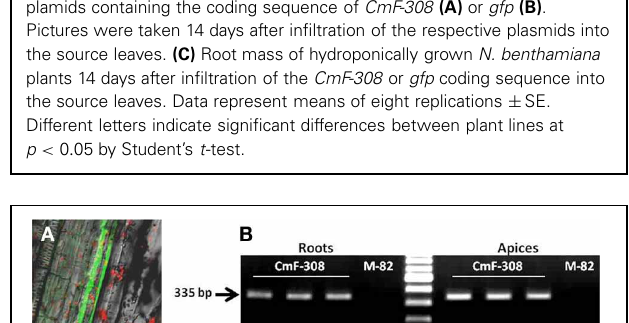
FIGURE 2 | Presence of CmF-308 transcript in the stems and apices of N. benthamiana plants 48h after agroinfiltration of source leaves with plasmid containing the coding sequence of this transcript, indicating long-distance movement of the transcript (A). Absence of the gfp transcript from the apices and stems and presence of the transcript in the agroinfiltrated leaf (B) . (C) Presence of the agrobacterium in the infected leaf 48h after agroinfiltration. C, negative control RT-PCR with no cDNA template. (D) Picture of the infiltrated N. benthamiana plant.